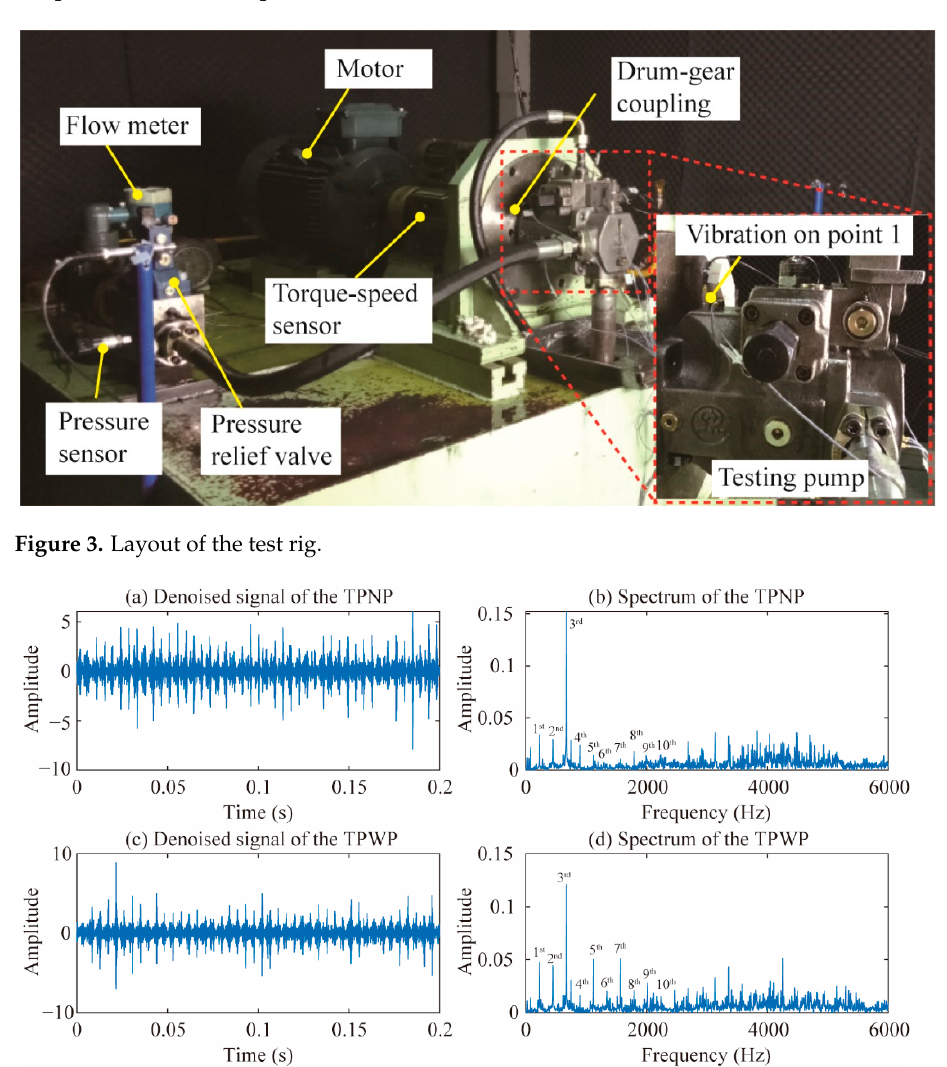
Figure 3. Layout of the test rig.